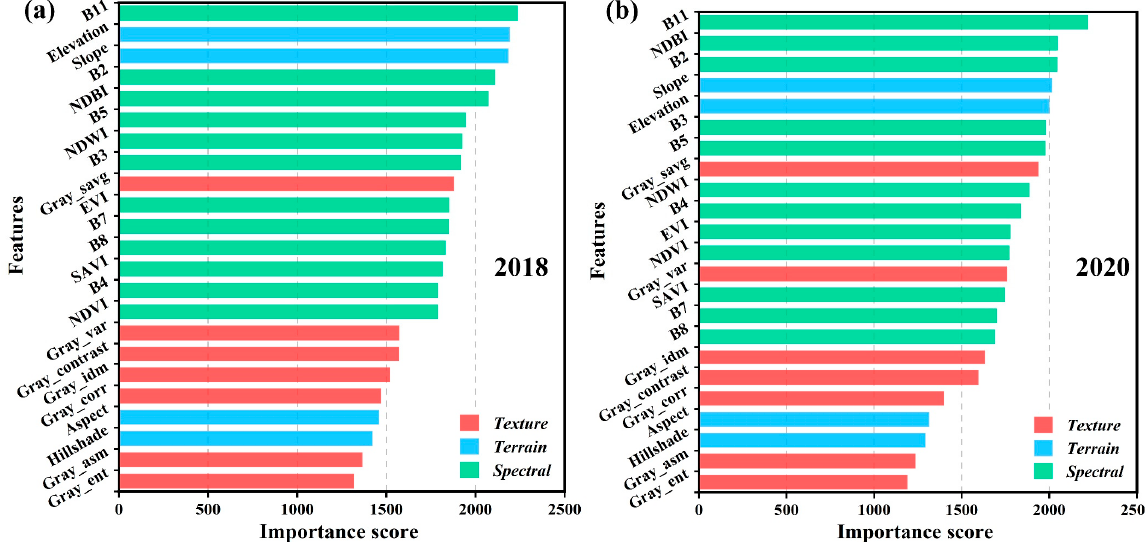
Figure 6. Average importance of features. ( a ) 2018; ( b )